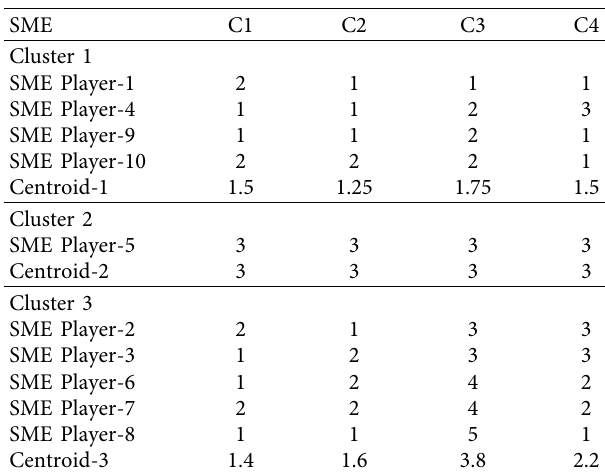
Table 18: Centroids in iteration